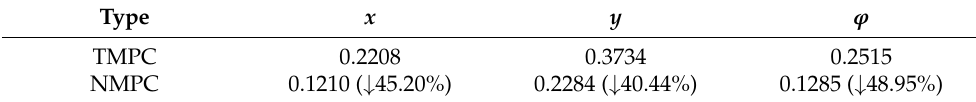
Table 3. The RMSE comparisons of the tracking errors of x , y , and ϕ under the SCT.